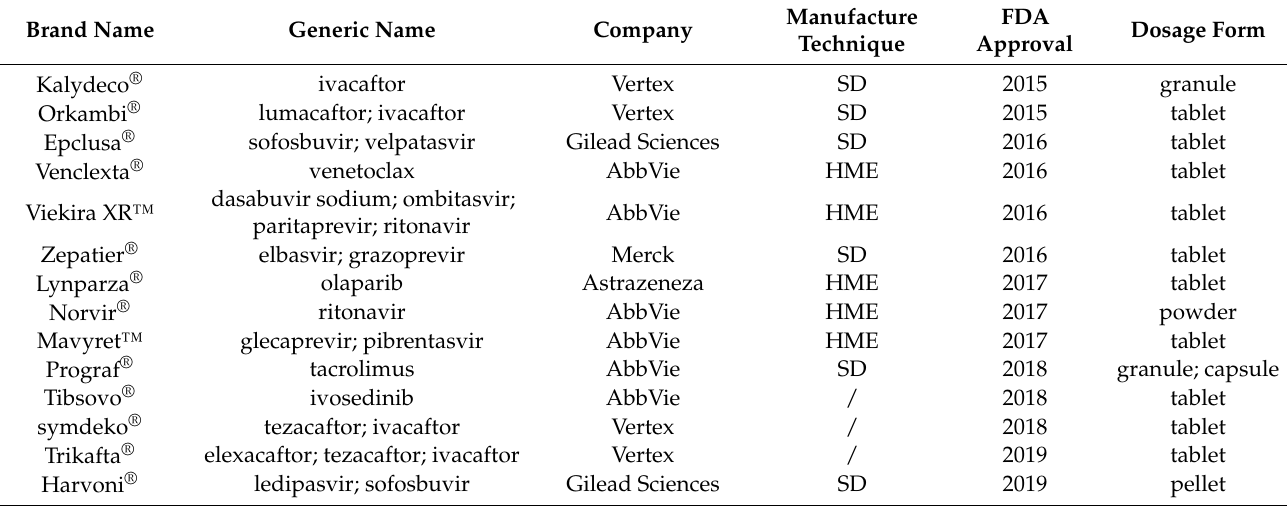
Table 1. Summary of ASD products granted FDA approval from 2015 to